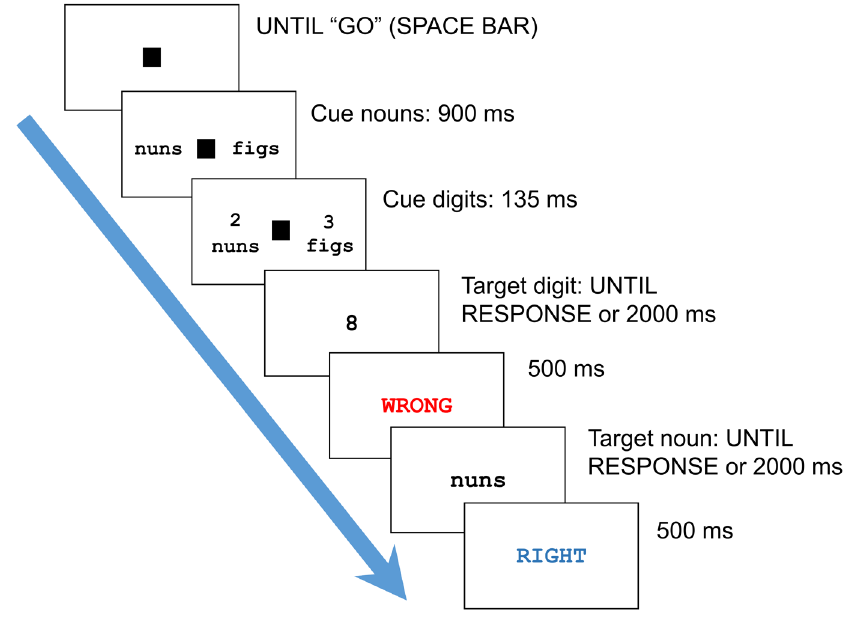
Figure 2. Illustration of the experimental procedure for the Number Matching task.